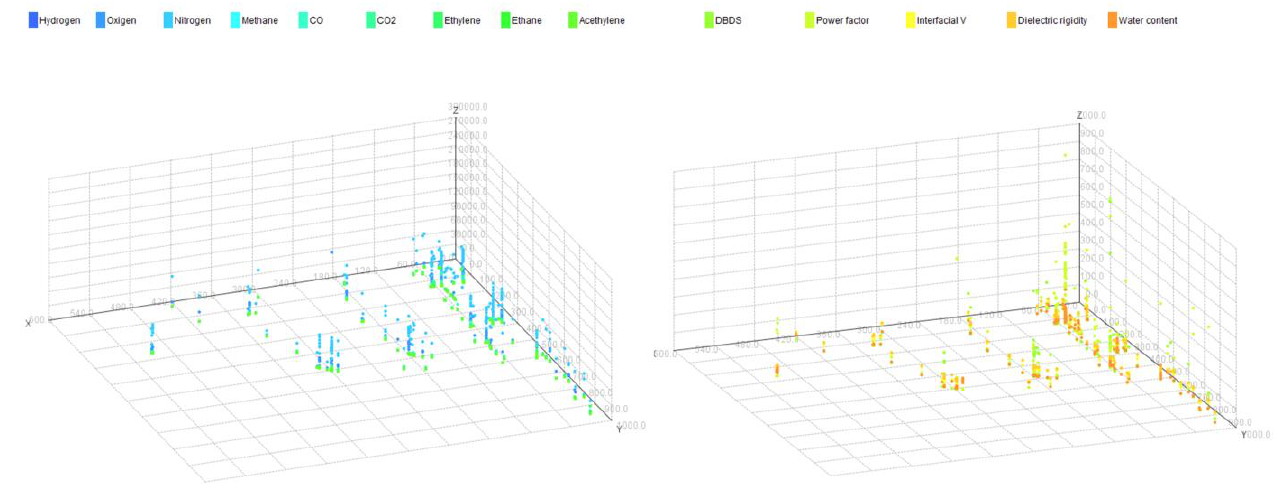
Figure 11. Health Index and life loss database.